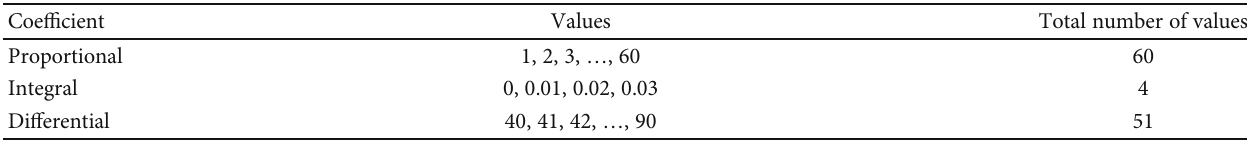
Table 7: Combinations of coe ffi cient in PID control.